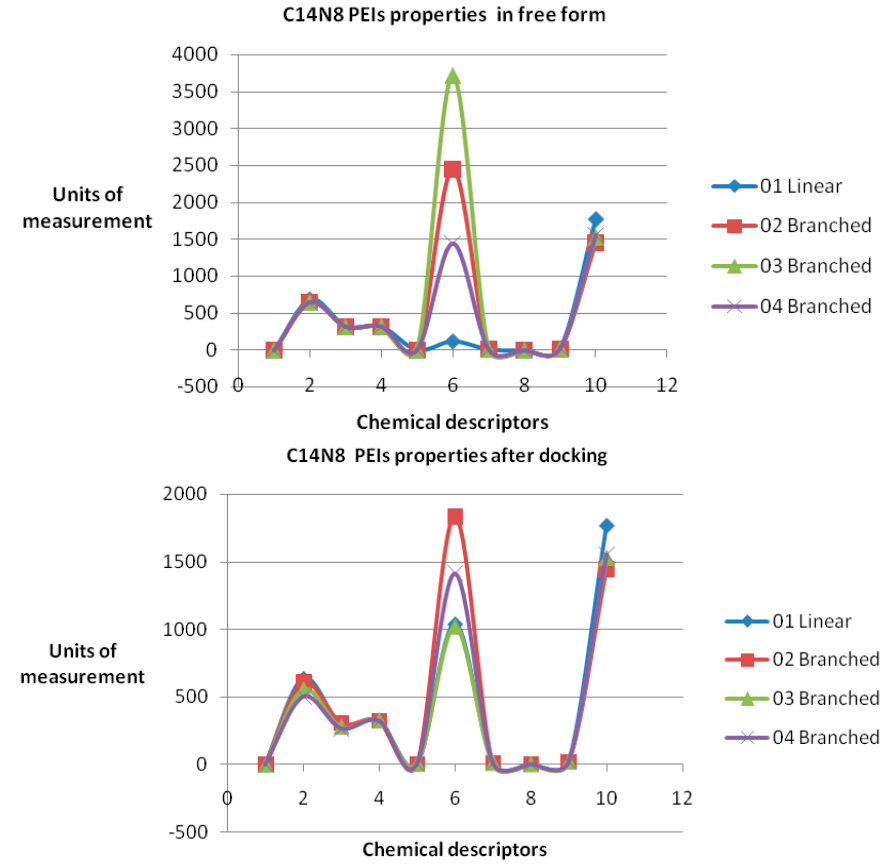
Figure 4. Chemical properties variation for C14N8 L/B PEIs i n the free (undocked)—( top ), and in docked form—( bottom ). 1—log P ; 2—Connolly accessible area (Å 2 ); 3—Connolly molecular area (Å 2 ); 4—Molecular weight; 5—Ovality; 6—Principal moment of inertia; 7—Molar refractivity (cm 3 /mol); 8—Partition coefficient; 9—Topological diameter (bonds); and 10—Wiener index.